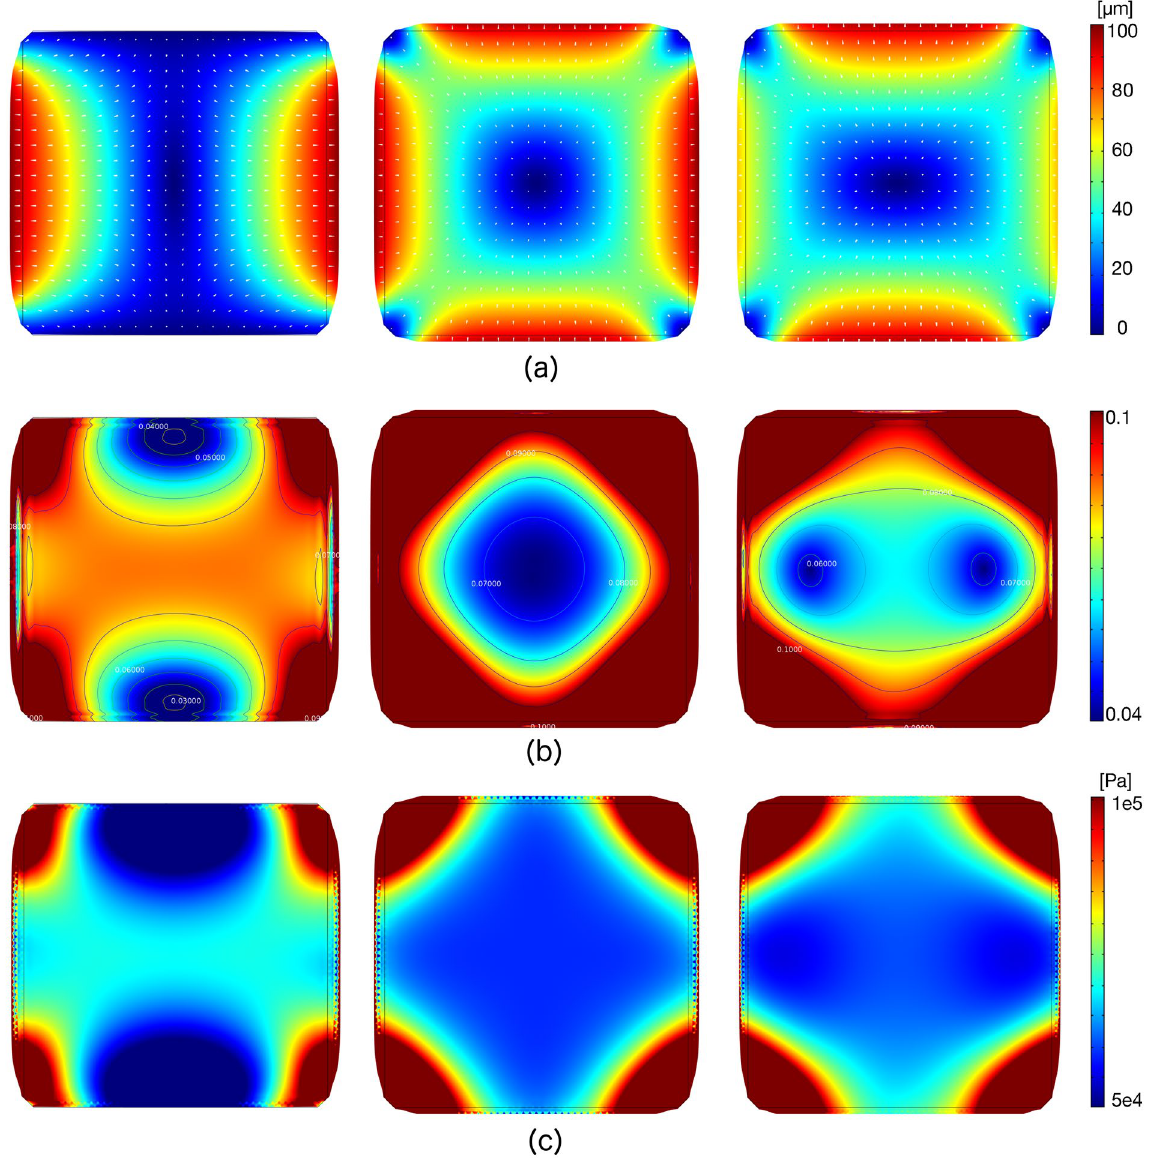
Figure 3. Results of numerical analysis. ( a ) Displacement field induced on the PM under uniaxial (left), equibiaxial (center) and biaxial 3:5 (right) loading patterns for a maximum pressure p = − 500 mbar . White arrows indicate the local horizontal and vertical components of the displacement field. ( b ) Color map and isolevel contours of the first invariant of deformation for the corresponding loading patterns. A limited range of strain values is displayed for the three cases, i.e. [0.04 ÷ 0.1]. ( c ) Color map of the von Mises stress